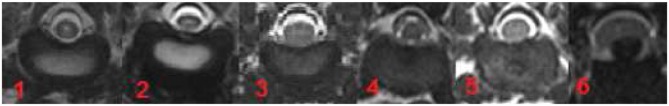
Grading system for T2W images modified after Pfirrmann et al. (14). Grade 1 and 2 included healthy intervertebral discs in dogs younger (grade 1) or older than 12 months (grade 2). Nucleus pulposus is hyper- or isointense to cerebrospinal fluid with a clear distinction between nucleus pulposus and annulus fibrosus. Grade 3 is characterized by mild degeneration affecting at the maximum one-third of the intervertebral disc with a iso- or hypointense nucleus pulposus and a visible distinction between nucleus pulposus and annulus fibrosus. Moderate degeneration (grade 4) affected at the minimum one-third and at the maximum two-third of the intervertebral disc, the distinction between nucleus pulposus and annulus fibrosus is blurred. In severe degeneration (grade 5) more than two-third of the intervertebral disc is affected, the nucleus pulposus is hypointense, narrowing of the cerebrospinal fluid space is possible. Disc herniations are displayed under “6”.